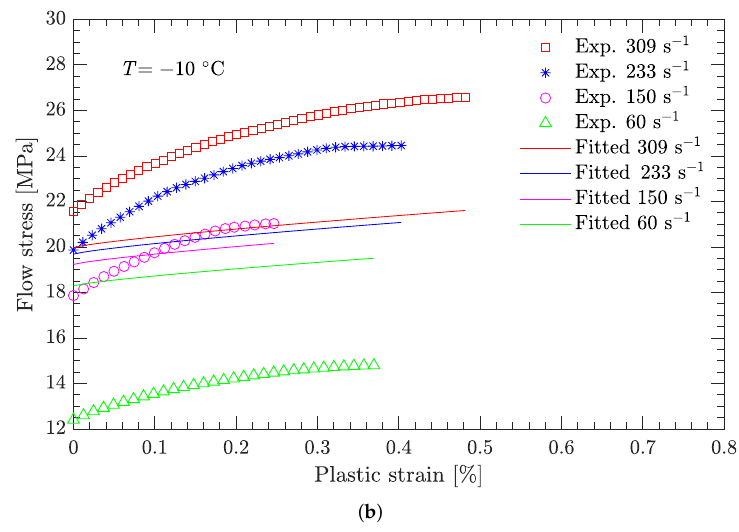
Figure 11. Comparison of fitted and measured flow stresses at a temperature of − 10 ◦ C. ( a ) Static compression; ( b ) dynamic compression.